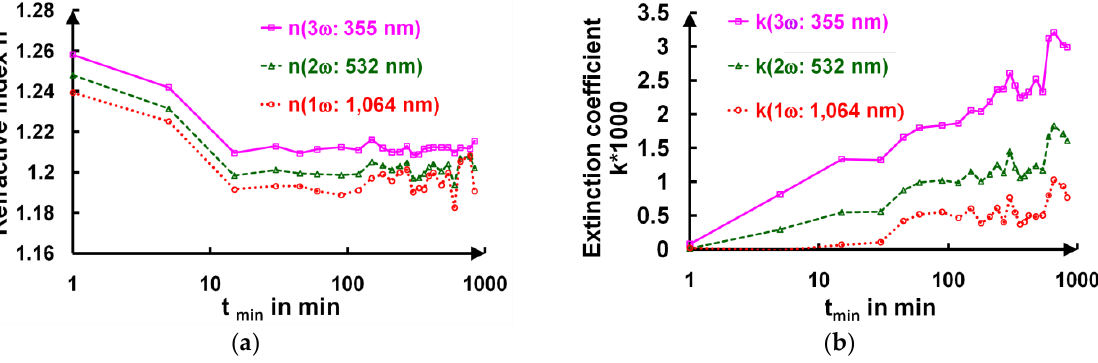
1 × 10 −3 , and this was mainly attributed to the appearance of the crazing.